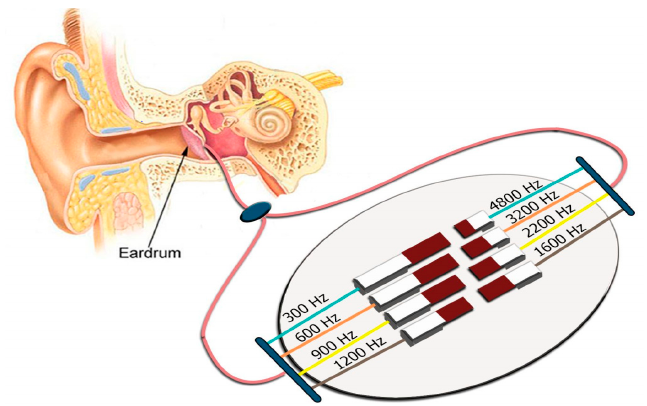
Figure 1. The proposed system for sensing the sound.